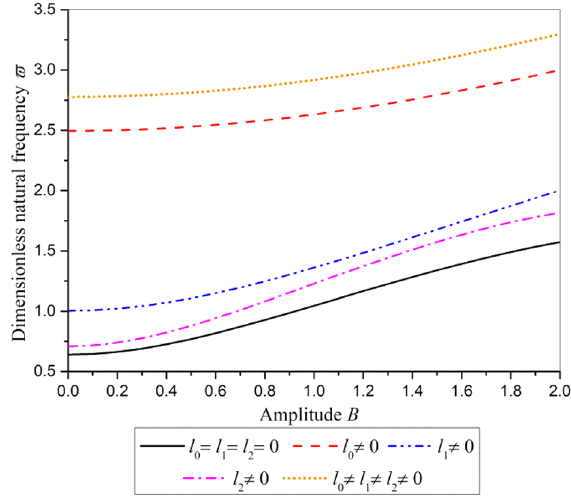
Figure 7. The influence of amplitude on dimensionless natural